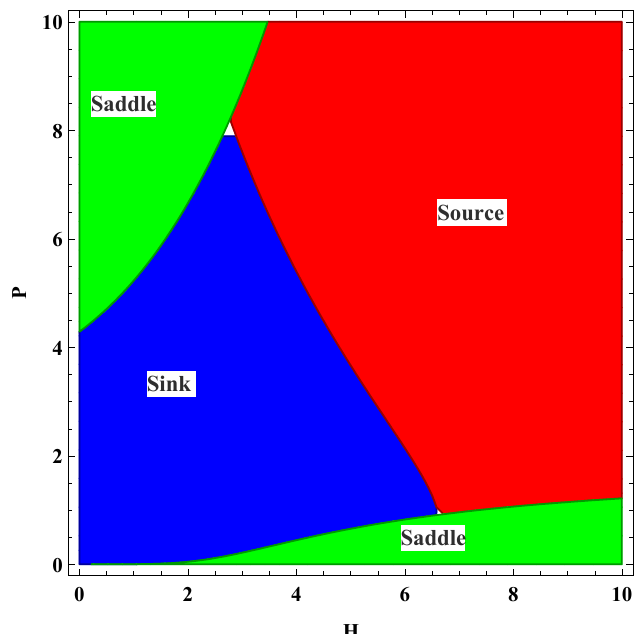
Figure 2. Topological classification for the positive fixed point of System